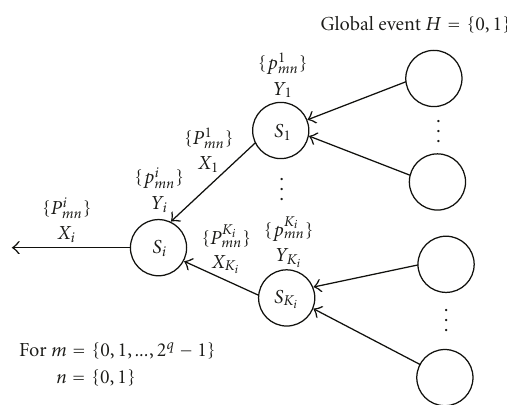
Figure 2: A local view of a tree topology showing an intermediate node S i with its K i children S 1 , S 2 , ... , S Ki . For any node S i , Y i represents its q -bit observation while X i corresponds to its q -bit